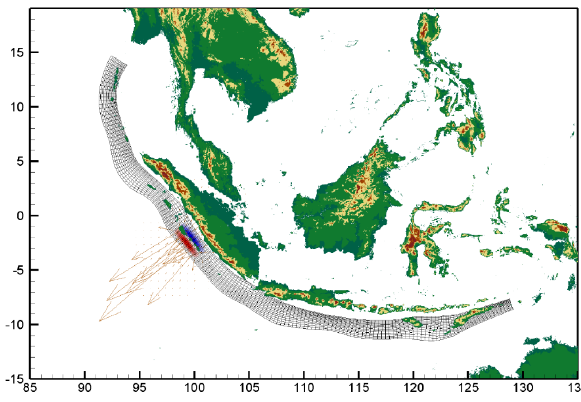
Fig. 2. Discretization model for the tsunamigenic Sunda plate interface (150 × 25 patches) based on Gudmundsson and Sam- Figure 2. Discretization model for the tsunamigenic Sunda plate interface (150x25 patches) bridge (1998). Also shown is initial wave and horizontal surface based on Gudmundsson and Sambridge (1998) and Engdahl et al. (2007). Also shown is initial displacements for a M w =8.4 scenario from the GITEWS scenario wave and horizontal surface displacements for a Mw=8.4 scenario from the GITEWS scenario databank.